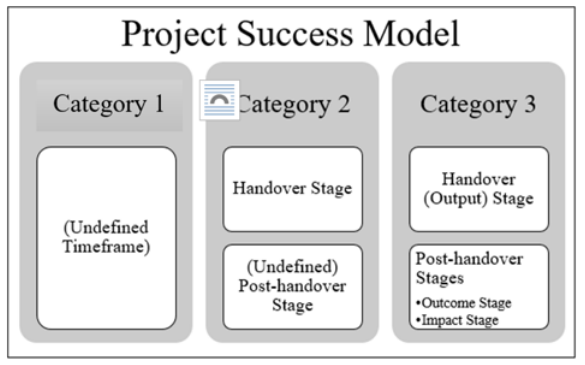
Figure 1 Categories of Project Success